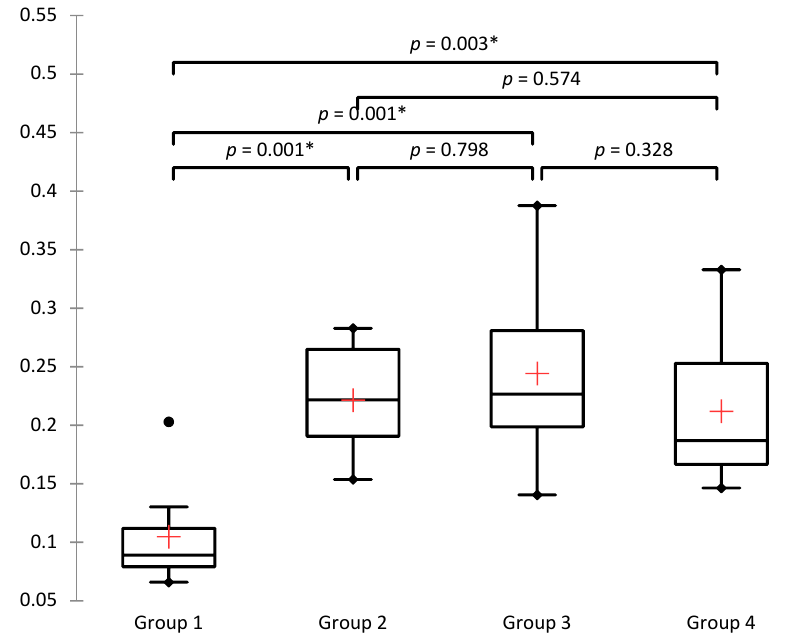
Figure 3. Box plots for malondialdehyde (nmol/ µ g). The Kruskal − Wallis test shows a statistically significant difference in the observed parameters between different groups (at a significance level of 5%); ( χ 2 = 14.395 (7.815), DF = 3, p = 0.002), * p < 0.05.